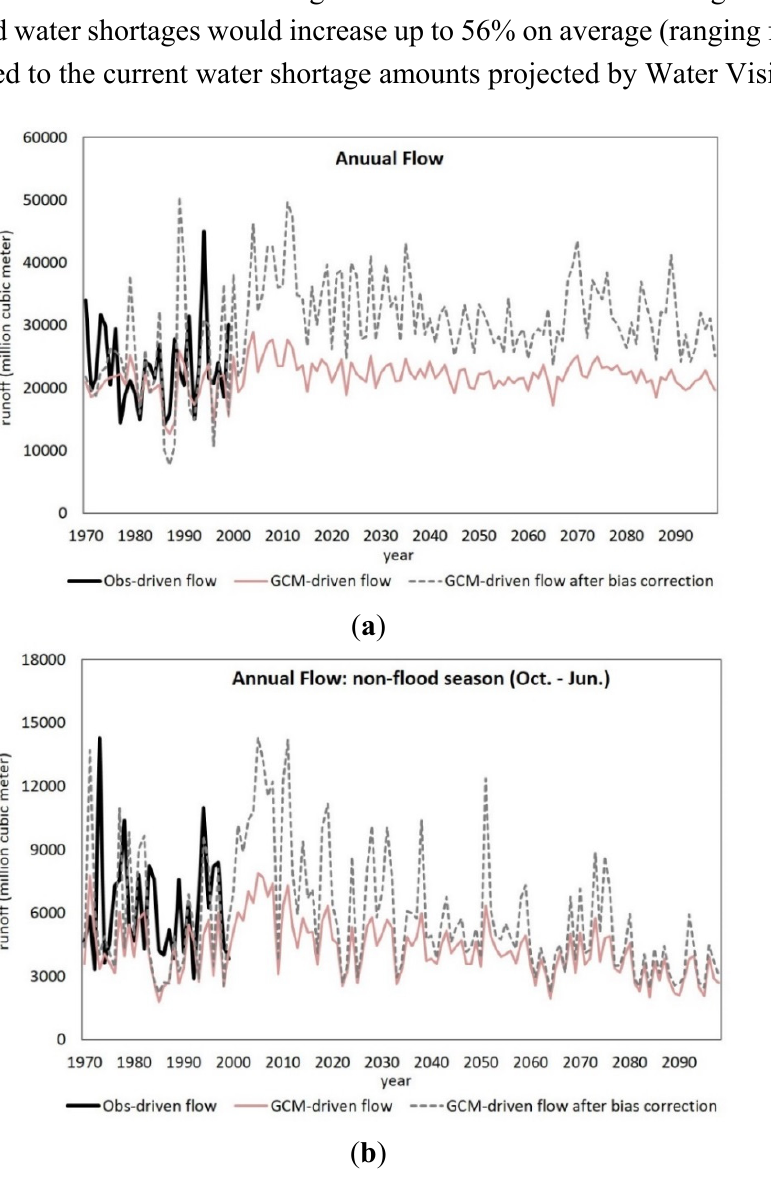
Figure 5. Annual flow comparison of observation-driven flow, GCM-driven flow (without bias correction), and GCM-driven flow after bias correction: ( a ) total annual flow; ( b ) non-flood season